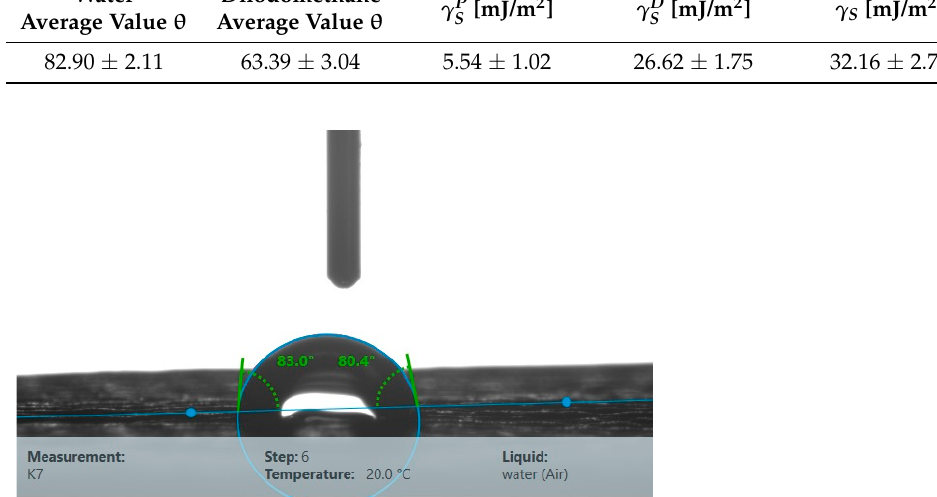
Figure 4. Determination of the contact angle θ of Kap 7. Table 1. The surface free energy for the Kap 7 sample.